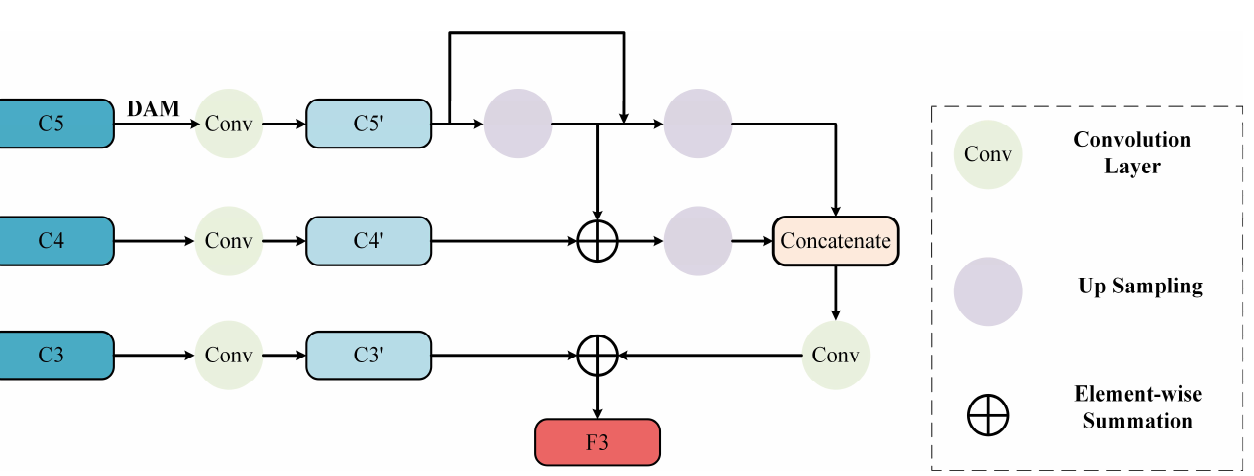
Figure 6. The architecture of dense feature fusion module (DFFM). Taking F3 as an example to illustrate the implementation of this module.